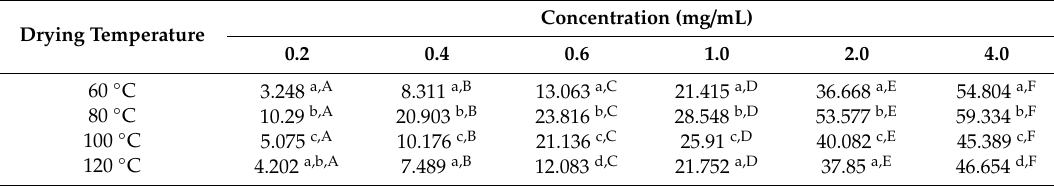
Table 1. DPPH (2,2-diphenyl-1-picrylhydrazyl) radical scavenging activity (% inhibition) of the extracts from Roselle dried at different temperatures.